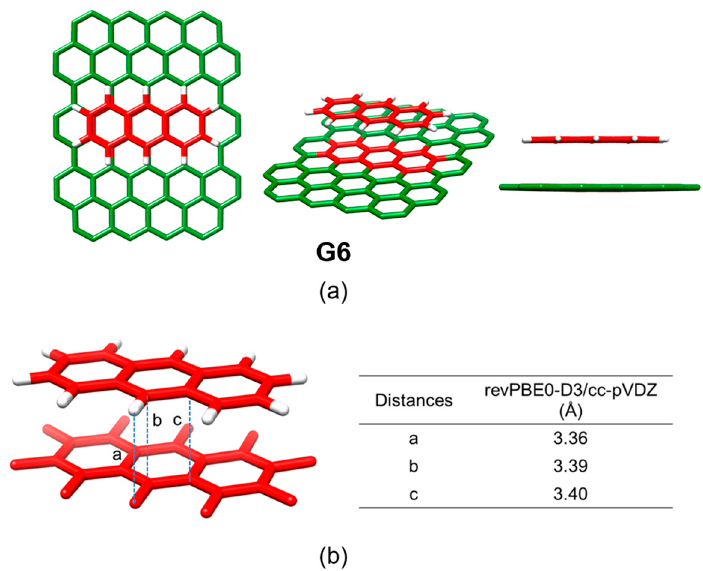
Figure 28. ( a ) Top and side views of the minimum-energy geometry computed for anthracene-graphene ( G6 ) at the revPBE0-D3/cc-pVDZ level. The intermolecular interacting regions of anthracene and graphene are colored in red; ( b ) Magnification of the interacting region emphasizing the most representative intermolecular distances collected in the table. Adapted with permission from [120]. Copyright 2013 WILEY-VCH Verlag GmbH & Co. KGaA.